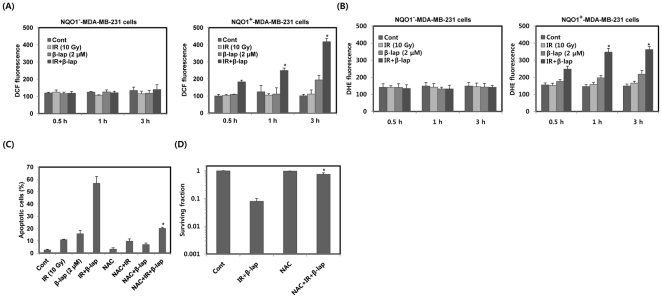
β-lap in combination with IR enhances ROS generation and leads to apoptotic cell death.(A) and (B) Cells were treated with IR alone, β-lap alone or combination of IR and β-lap for the indicated times. After 3 h, the cells were incubated with 10 µM H2DCF-DA and 4 µM DHE, respectively, for 30 min and then analyzed by flow cytometry. Results from three independent experiments are expressed as means ± SEMs. (C) NQO1+-MDA-MB-231 cells were treated with IR alone, β-lap alone or combination of IR and β-lap for 24 h in the presence or absence of NAC (10 mM). After 24 h, the percentage of cells with sub-G1 DNA content was determined by flow cytometry. Results from three independent experiments are expressed as means ± SEMs. (D) NQO1+-MDA-MB-231 cells were treated with combination of IR (2 Gy) and β-lap (2 µM) in the presence or absence of NAC (10 mM). Cells were allowed to grow for 10 to 14 days and were stained with 0.5% crystal violet and scored for colony formation. Results from three independent experiments are expressed as means ± SEM. *Significant difference between cells in the presence or absence of NAC after combined treatment with IR and β-lap, at p<0.05.